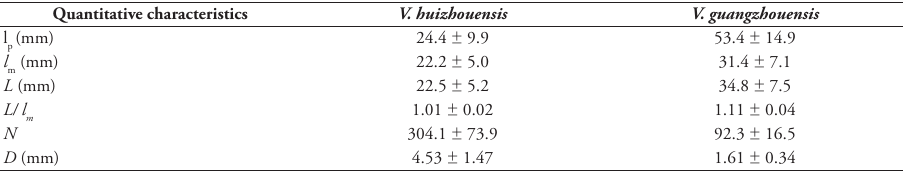
Table 2. Quantitative characteristics and significant difference analysis of the species V. huizhouensis and V. guangzhouensis